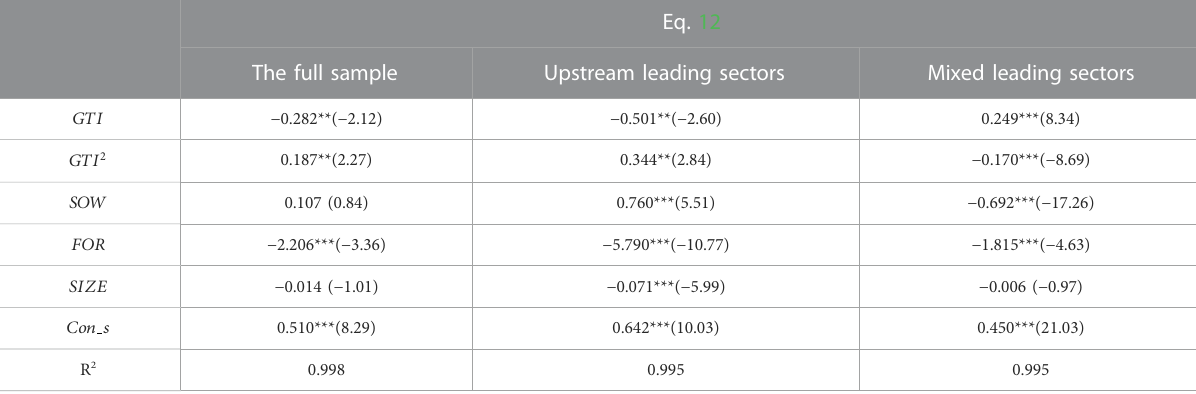
TABLE 7 Robustness regression results of green technology innovation and GVC upgrading in subsectors of equipment manufacturing